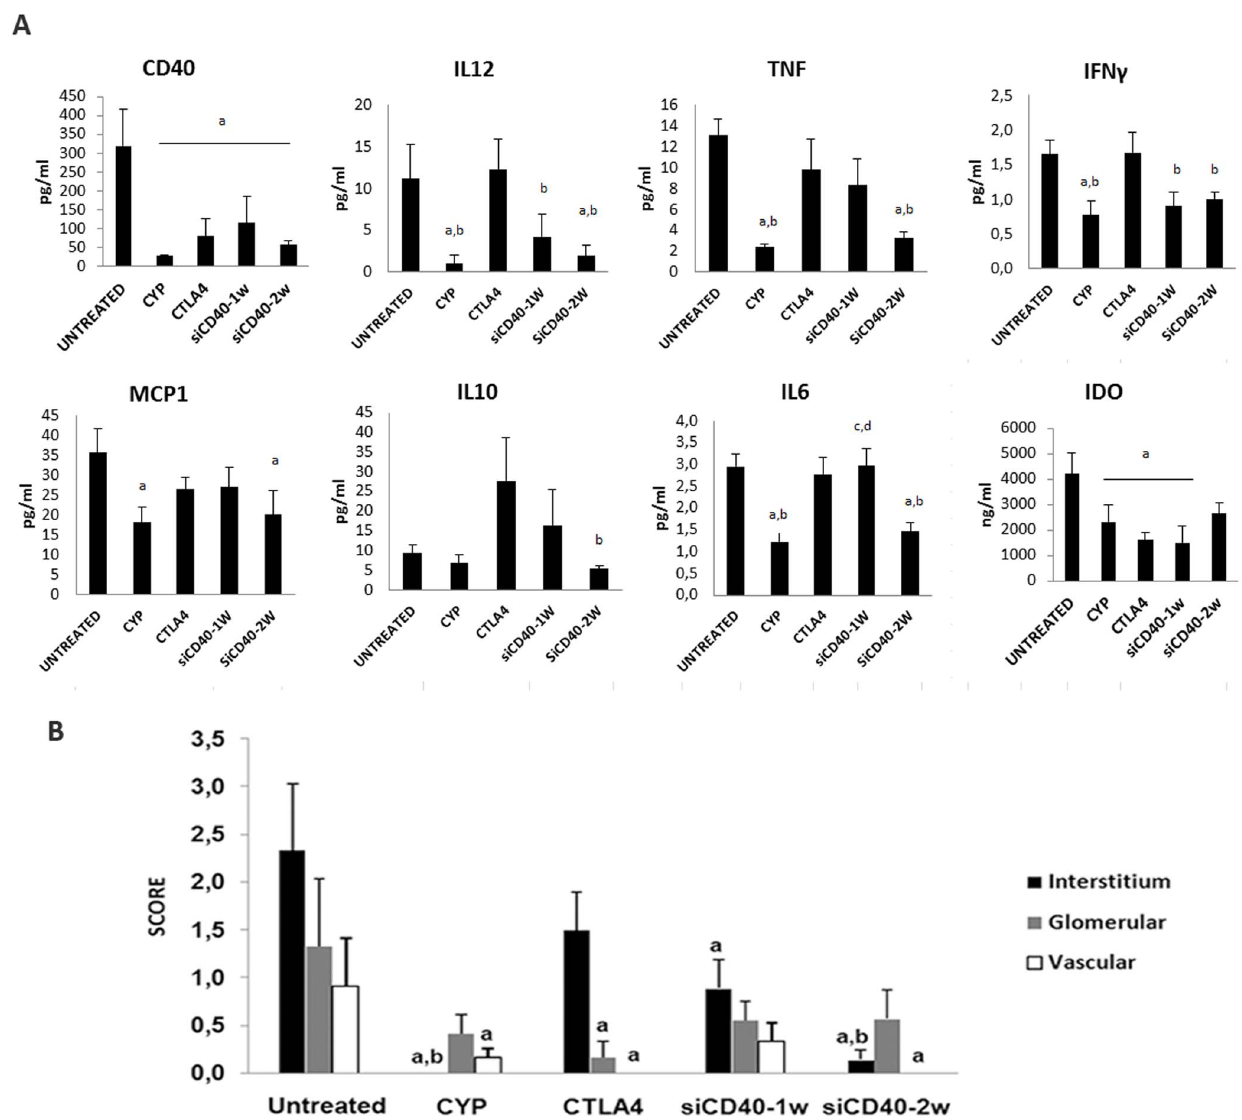
Figure 7. Systemic circulating inflammatory cytokines and local CD40 immunostaining. A) Lupus nephritis promoted over-expression of CD40 protein in serum, this immune modulatory protein was reduced in all therapies. Lupus nephritis also induced the increase in other inflammatory cytokines, treatment with siRNA anti CD40 reduced some of them. B) Immune localization and quantification of CD40 protein in different kidney compartments, Chol-siRNA reduced CD40 protein, especially in interstitial cells and vessels. Data are expressed as mean 6 SEM. a p , 0.05 vs untreated; b vs CTLA4, c vs CYP and d vs siCD40-2w.